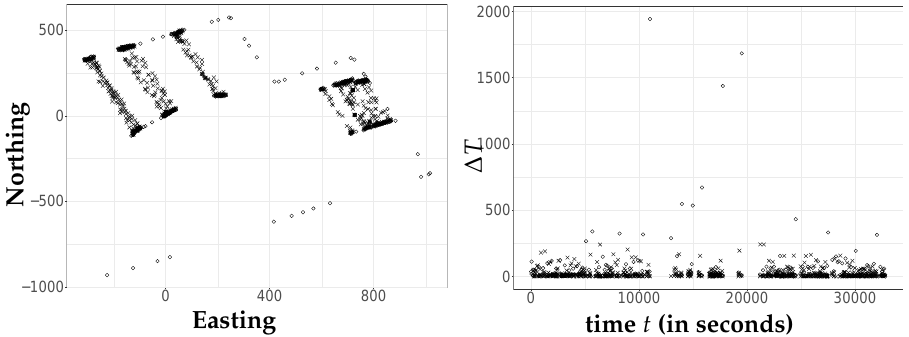
Figure 2. A real GPS data set of tractor movements. Observed positions in two dimensions on the left and irregular time differences indicated on the right. In trajectory reconstruction, the positions are combined with velocity information and operating characteristics of the tractor to infer actual positions for times of interest. Crosses indicate the boom is working; circles indicate it is not